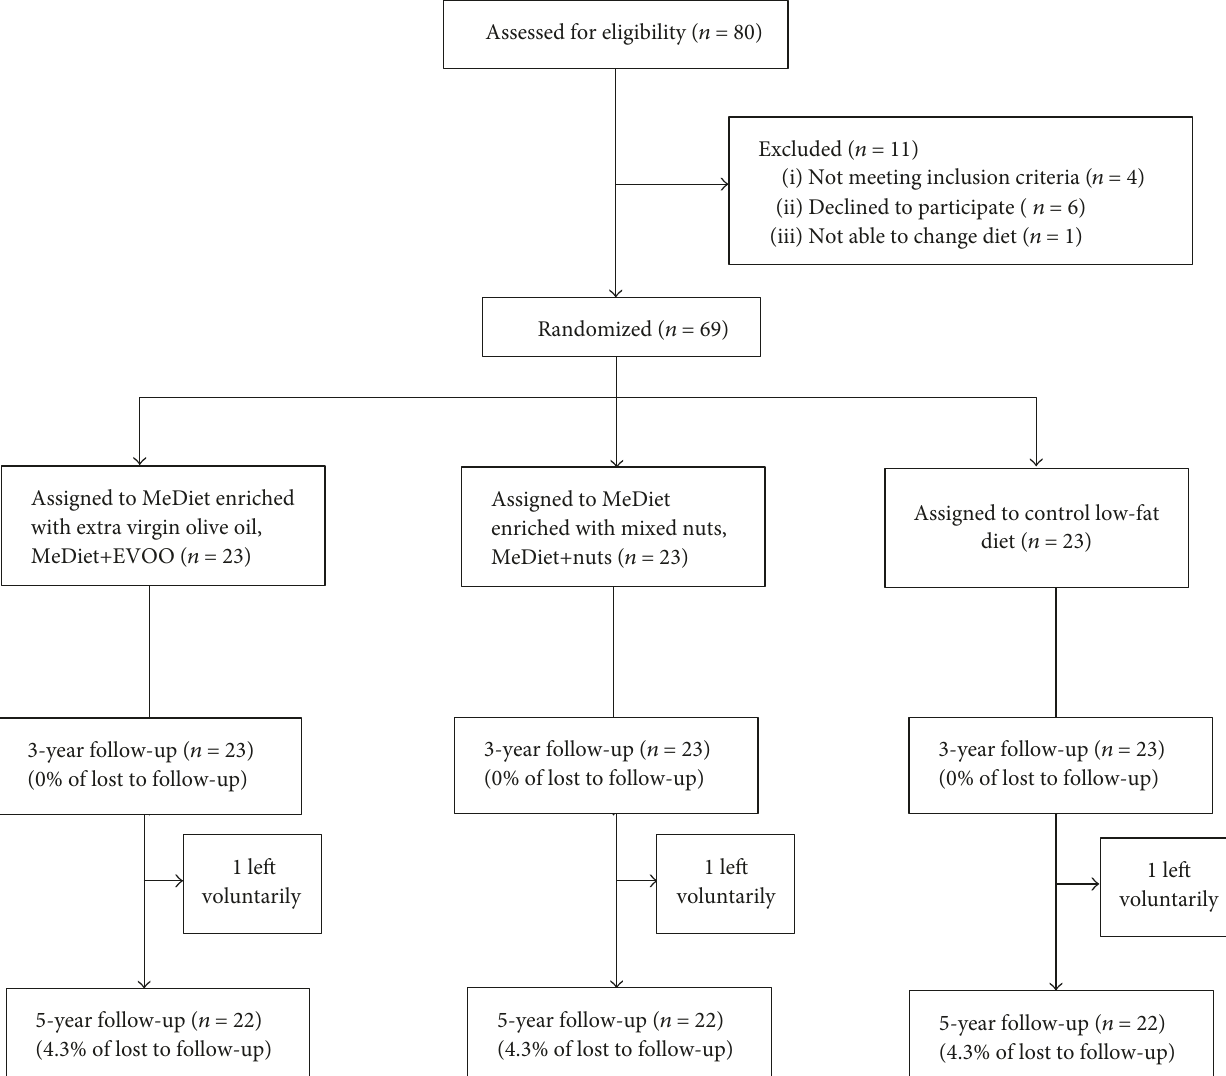
Figure 1: Flowchart of the study participants. The diagram includes detailed information on the participants excluded. EVOO: extra virgin olive oil; MeDiet: Mediterranean